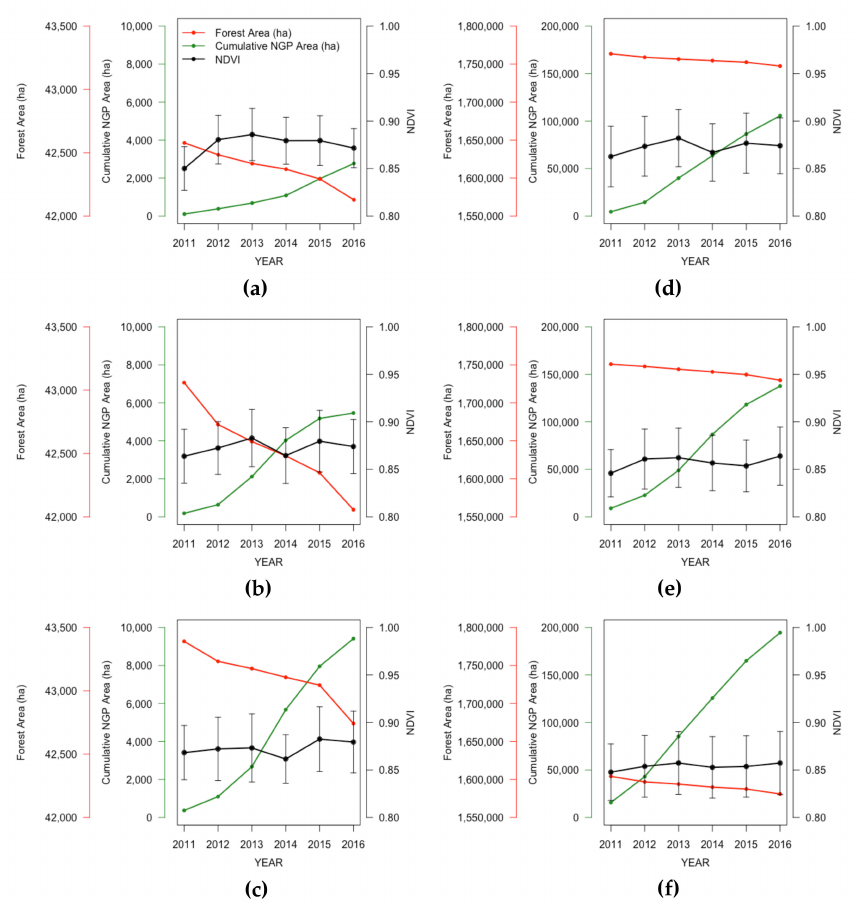
Figure 4. Yearly MODIS NDVI averages (black), accumulated forest loss (red) as derived by Hansen et al. [14], and NGP area (green) as provided by the Department of Environment and Natural Resources (DENR) in ( a ) Site 1; ( b ) Site 2; ( c ) Site 3; ( d ) the Sierra Madre; ( e ) Cordillera; and ( f ) the rest of the Luzon